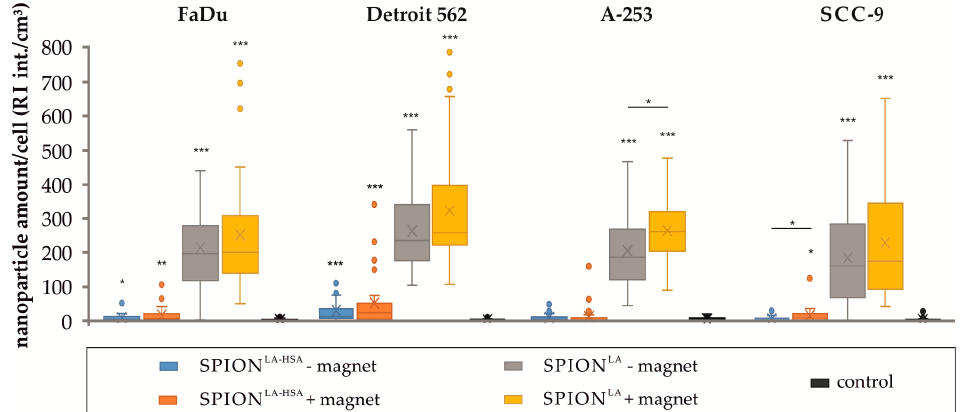
Figure 3. Nanoparticle amount quantified by RI analysis. The amount of SPIONs in different head and neck tumor cell lines treated with 100 µg Fe /mL SPION LA or SPION LA-HSA in the presence or absence of external magnets was determined by the presence and quantification of structures with high RI. Statistical significances are indicated with *, ** and ***. The respective confidential intervals are p ≤ 0.05, p ≤ 0.01, and p ≤ 0.001 and were calculated via t -test analysis. Asterisks on individual bars indicate the significance between SPION-treated cells and control samples and asterisks on connecting lines indicate the significance between samples incubated with SPIONs in presence or absence of magnets. Abbreviations: SPION, superparamagnetic iron oxide nanoparticles; SPION LA , lauric acid-coated SPIONs; SPION LA-HSA , lauric acid- and human serum albumin-coated SPIONs; RI int., refractive index intensity.